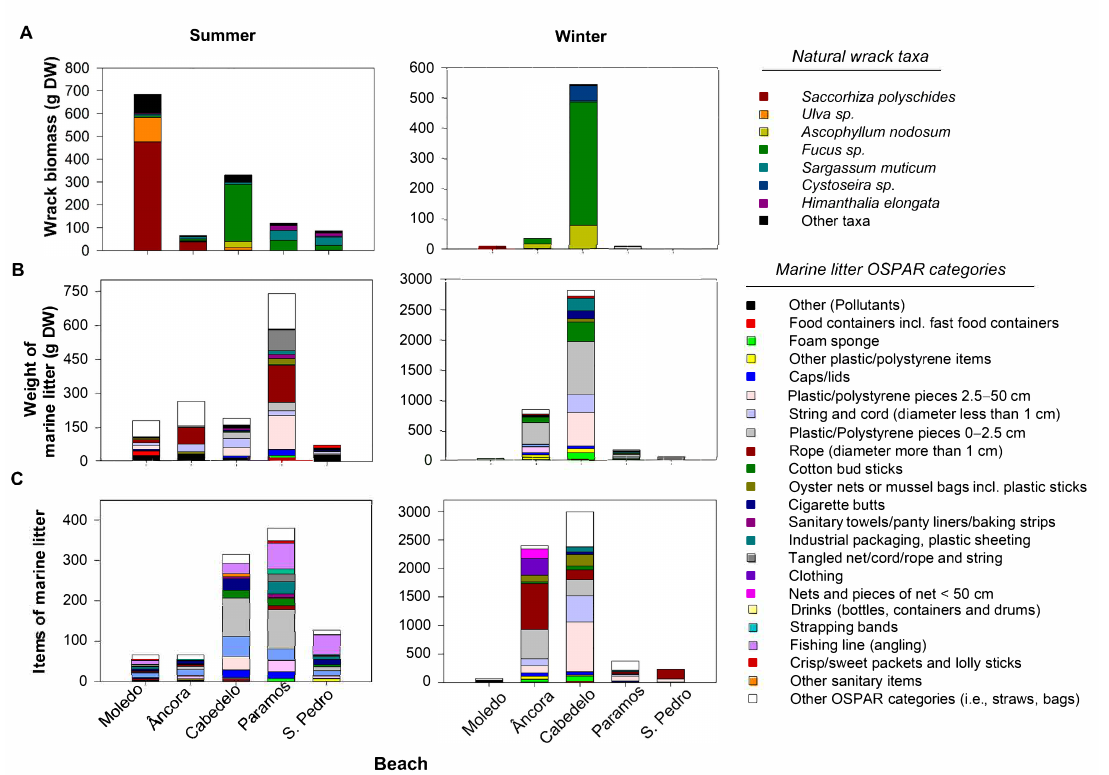
Figure 5. Total biomass and main taxa which composed the natural wrack classified at the lower level of aggregation ( A ) and weight ( B ) and number of items ( C ) of the main OSPAR categories which formed the marine litter on each beach of the North of Portugal in the summer of 2019 and in the winter of